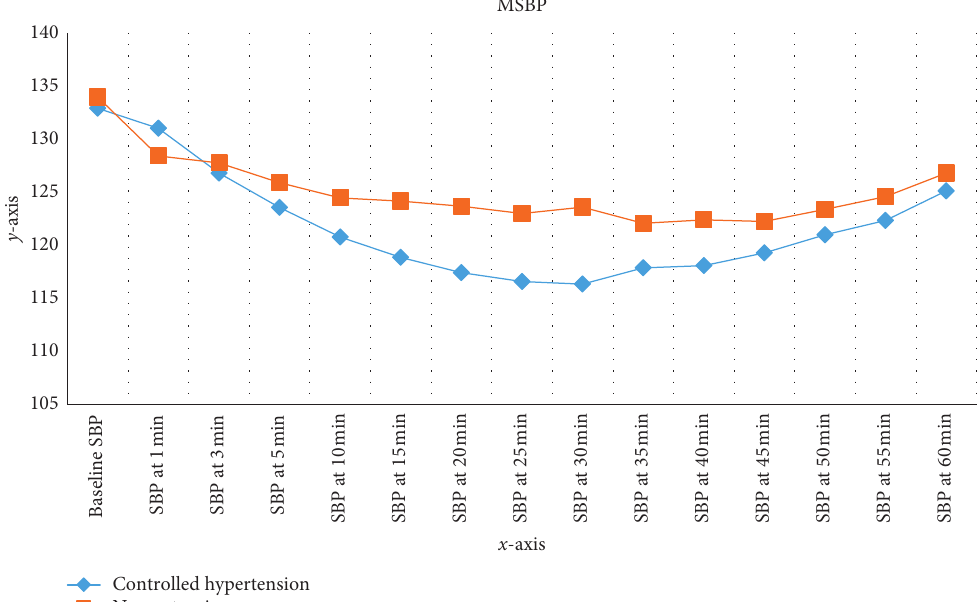
Figure 2: Variation in the systolic blood pressure (SBP) between two groups. The changes from baseline of the SBP in the first one hour after spinal anesthesia ( x -axis duration and y -axis mean of SBP in mmHg) at Black Lion Hospital from October 30, 2019, to January 30, 2020. Table 3: Comparison of the incidence of hypotension, bradycardia, vasopressor consumption, and atropine usage in response to bra- dycardia between the two groups: at Black Lion Hospital from October 30, 2019, to January 30, 2020. Parameter CH ( n � 55)